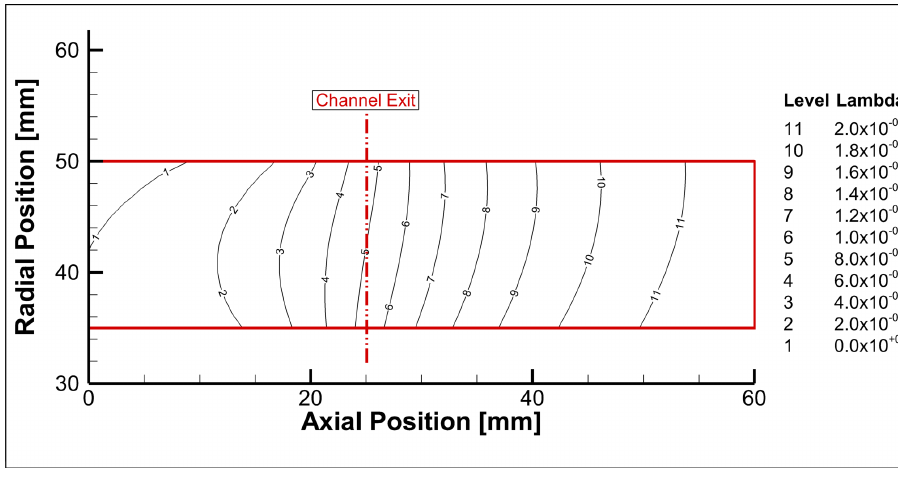
Figure 10. SPT-100: magnetic stream function ( λ ) computed from magnetic